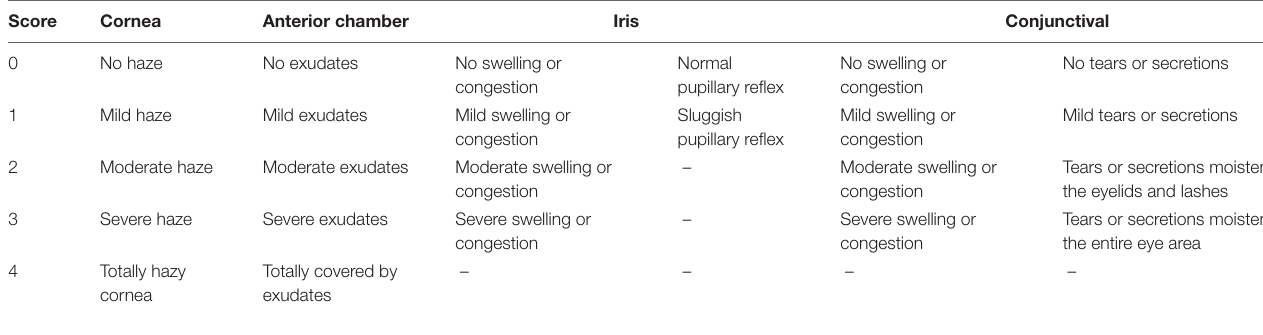
TABLE 1 | Scores of inflammation severity of ocular tissues (Draize et al.,